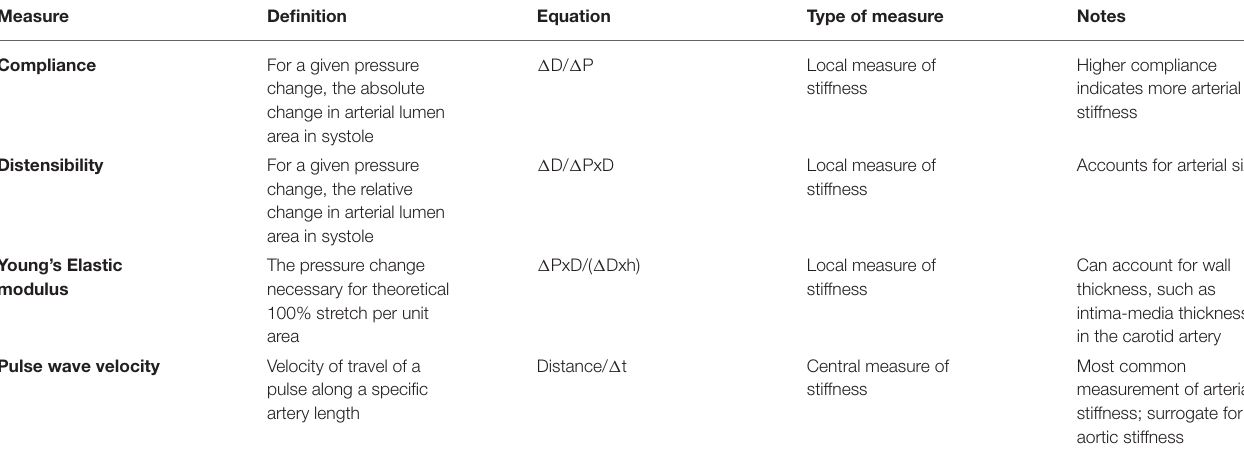
TABLE 1 | Overview of arterial stiffness measurement techniques.